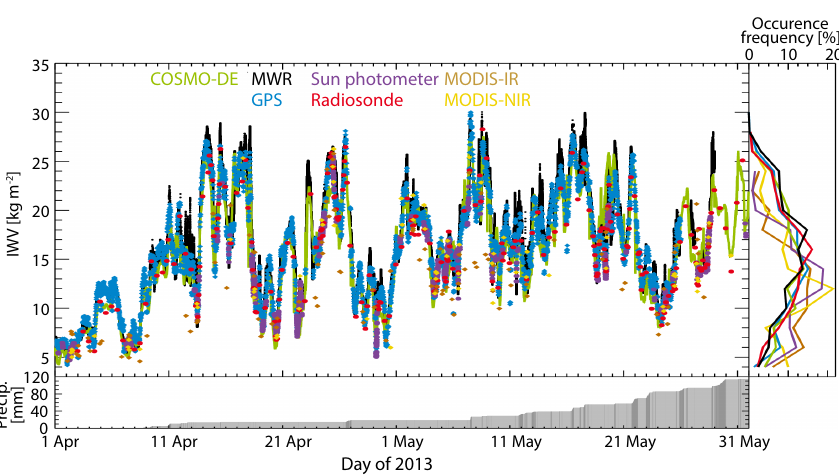
Figure 8. Observation of the integrated water vapour (IWV) during HOPE-Jülich for a large suite of different instruments. Right panel shows the frequency distribution of the IWV values recorded with the different techniques. Bottom panel shows the accumulated amount of precipitation. Adapted from Steinke et al. (2015).